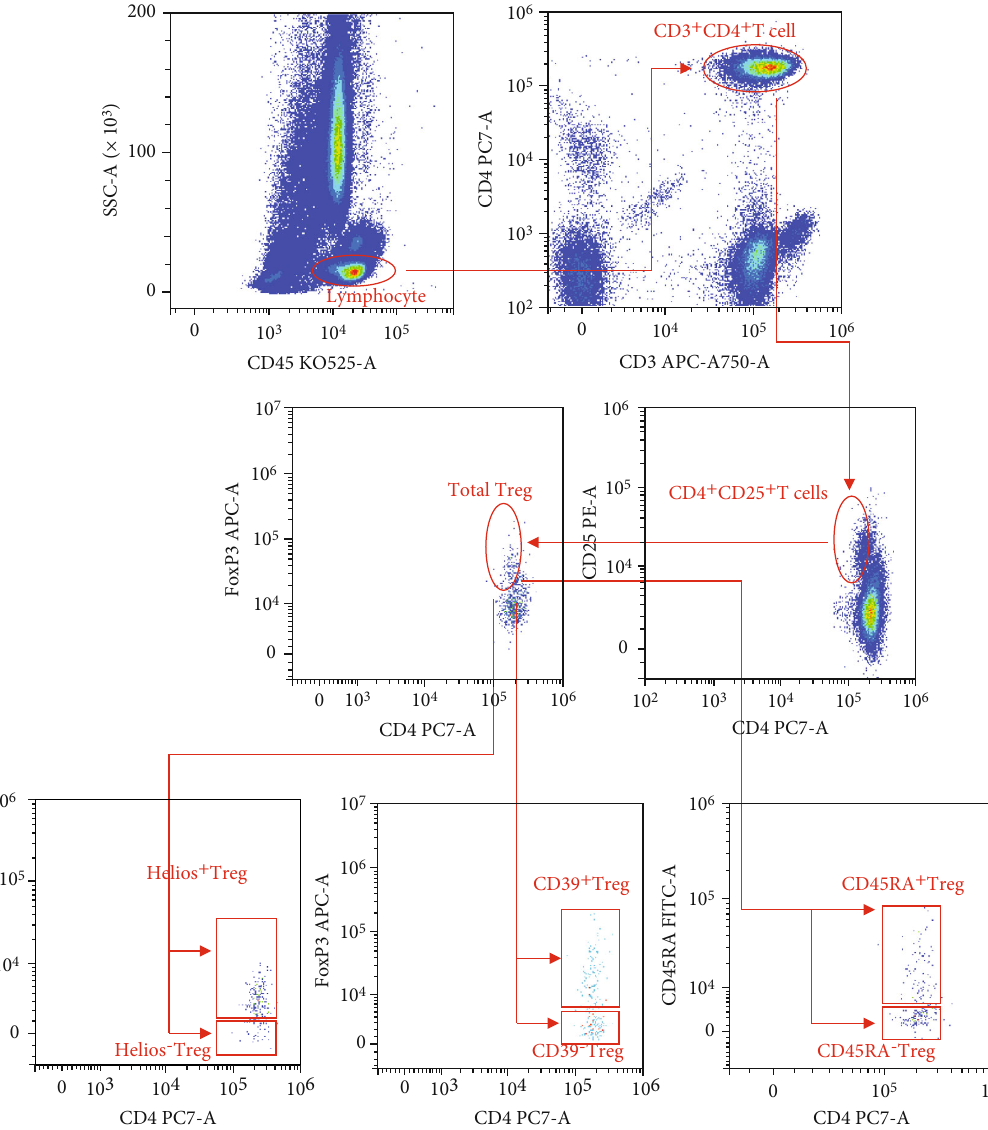
Figure 1: Gating strategies for Treg subpopulations. The fi rst gate was on lymphocytes based on CD45 and SSC-A, and then, CD3 and CD4 were used to gate CD3 + CD4 + T cells. CD25 and FoxP3 together were used to identify total Treg. Helios, CD39, and CD45RA were used to de fi ne six subpopulations of Treg: Helios +/- Treg, CD39 +/- Treg, and CD45RA +/-